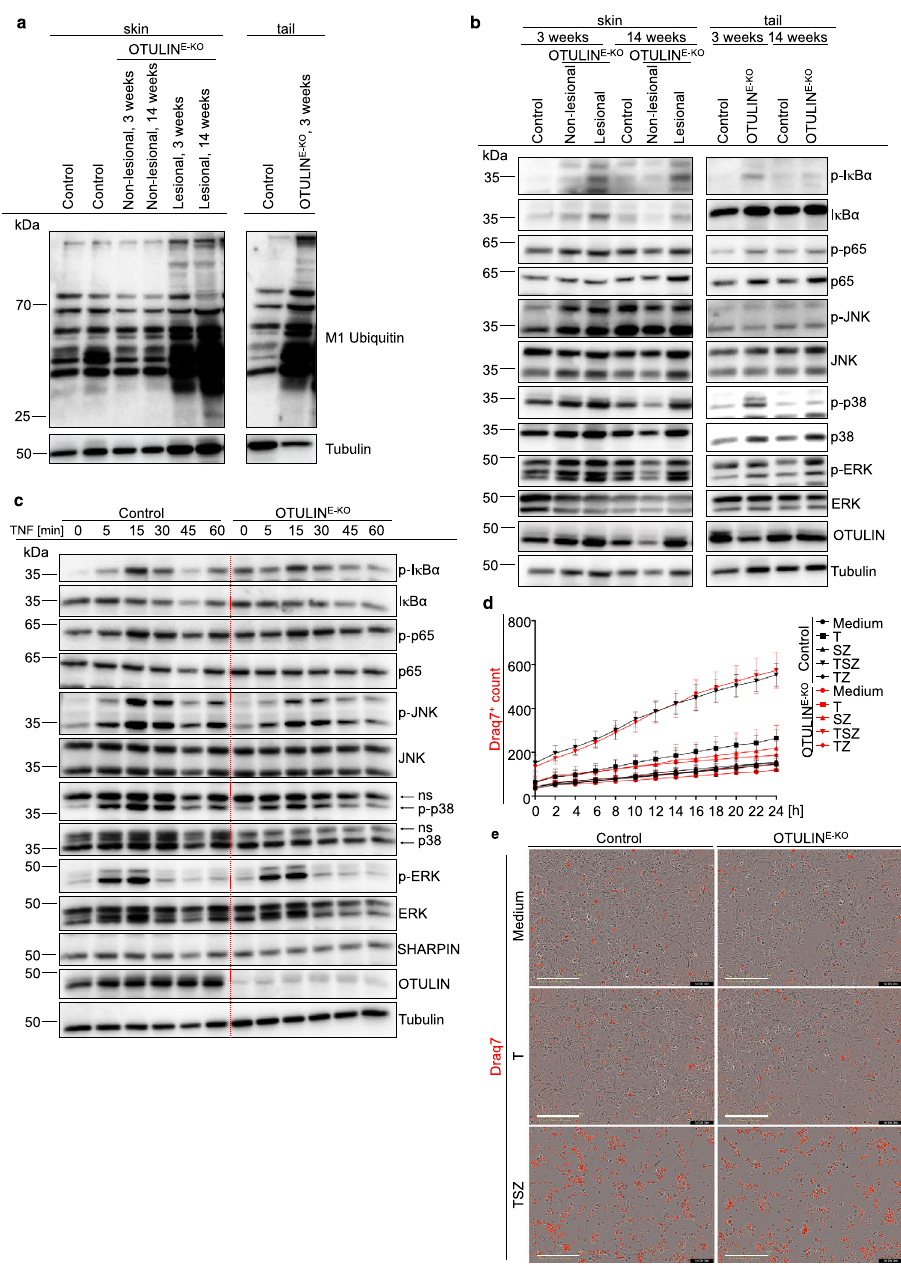
Fig. 3 Normal TNF-induced in fl ammatory and cell death signalling in OTULIN-de fi cient primary keratinocytes. a Representative immunoblot analysis of protein extracts from lesional and non-lesional skin or tail tissue from 3- or 14-week-old OTULIN E-KO or control mice with antibodies against linear (M1- linked) ubiquitin chains or tubulin as loading control ( n = 3). b Representative immunoblot analysis of protein extracts from lesional or non-lesional skin and tail tissue from 3- or 14-week-old OTULIN E-KO mice or WT mice with the indicated antibodies ( n = 4). c Representative immunoblot analysis with the indicated antibodies of protein extracts from primary keratinocytes derived from OTULIN E-KO mice or control mice stimulated with TNF for the indicated timepoints ( n = 4). ns = non-speci fi c. d Cell death measured by Draq7 uptake in primary keratinocytes from OTULIN E-KO and control mice treated with combinations of TNF (T) (20 ng ml − 1 ), SMAC mimetic (S, Birinapant) or Z-VAD-fmk (Z) for 24 h. Graph shows mean ± s.e.m values from technical duplicates ( n = 6). e Representative images from primary keratinocytes of the indicated genotypes treated with combinations of T (20 ng ml − 1 ), S or Z for 24 h ( n = 6). Dead cells are stained red from Draq7 uptake after 24 h. Scale bar = 400 μ m. Control mice include littermates of OTULIN E-KO mice that do not express K14-Cre . Control mice include littermates that do not express K14-Cre . Source data for a – d are provided as a Source data fi